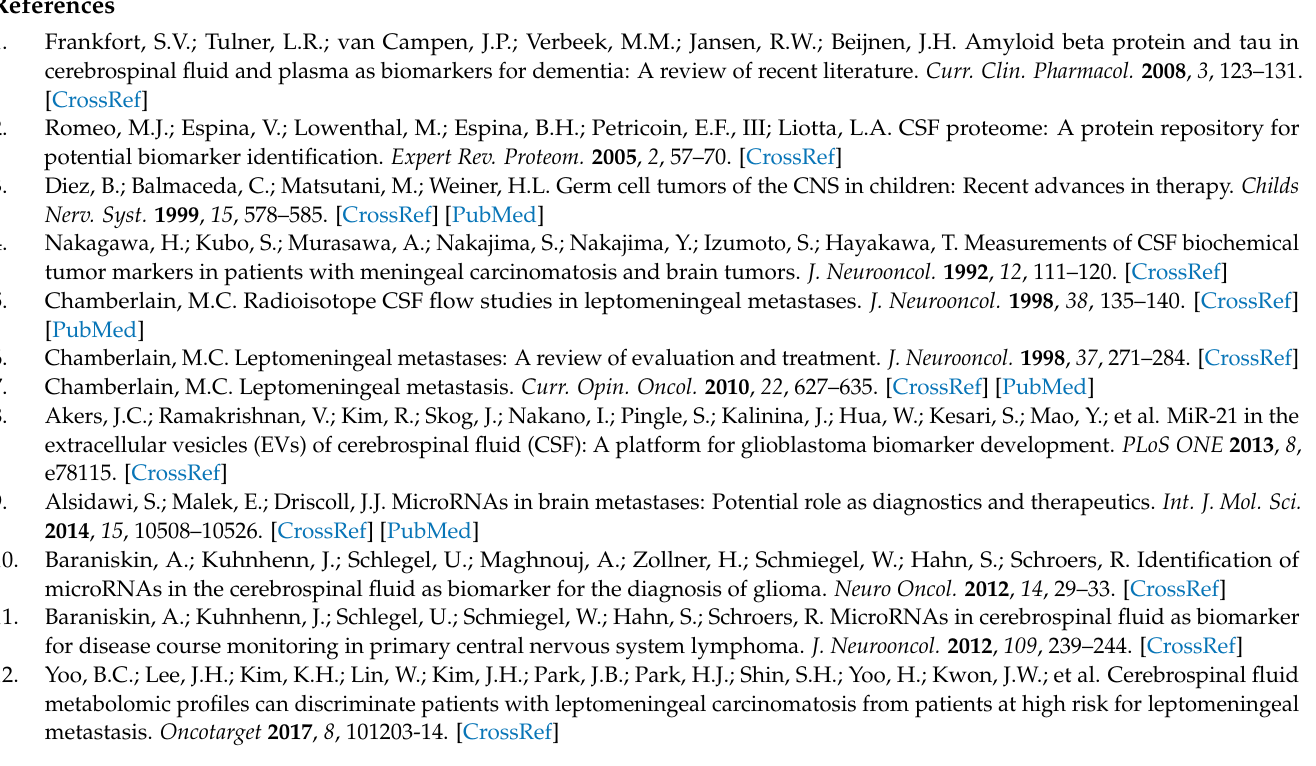
site of CSF samples. Table S2A: List of differentially expressed miRNAs between each patients groups by significance analysis of microarrays. CC vs. HC. Table S2B: List of differentially expressed miRNAs between each patients groups by significance analysis of microarrays. LM vs. Control. Table S2C: List of differentially expressed miRNAs between each patients groups by significance analysis of microarrays. BM vs. Control. Table S2D: List of differentially expressed miRNAs between each patients groups by significance analysis of microarrays. BT vs. Control. Table S2E: List of differentially expressed miRNAs between each patients groups by significance analysis of microarrays. LM vs. BM. Table S2F: List of differentially expressed miRNAs between each patients groups by significance analysis of microarrays. LM vs. BT. Table S2G. List of differentially expressed miRNAs between each patients groups by significance analysis of microarrays. BM vs.